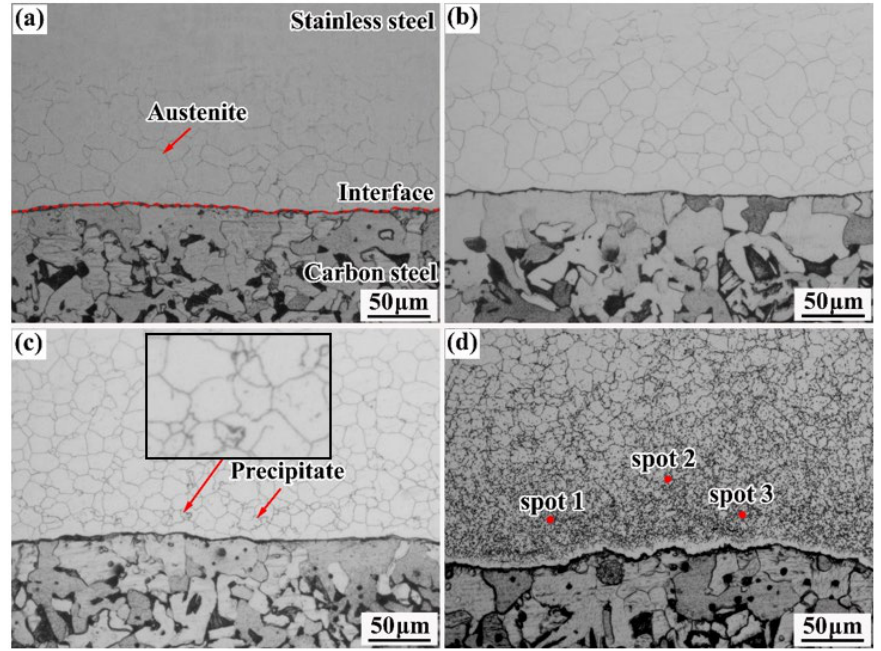
Figure 8. Metallographic images of the stainless-steel side of various rebars: ( a ) 20MnSiV/316L rebar; ( b ) 35#/316L rebar; ( c ) 45#/316L rebar; ( d ) 55#/316L rebar.